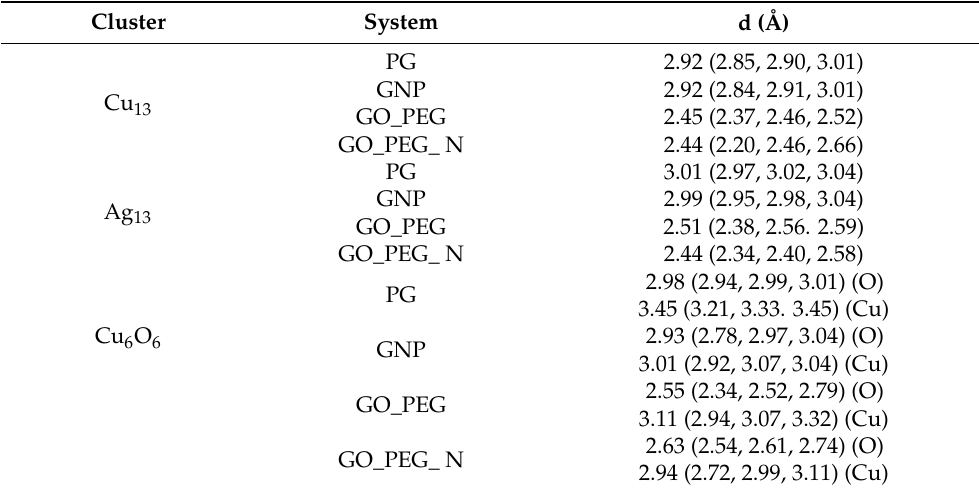
Table 2. Mean equilibrium distances between the cluster and nearest graphene surface atoms. The values obtained from each individual simulation are shown in parentheses.